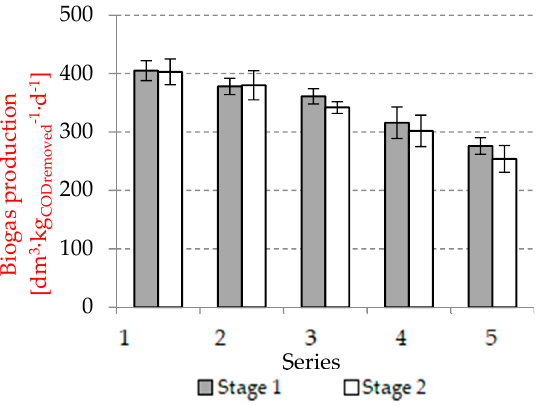
Figure 7. Daily biogas production per COD load removed.